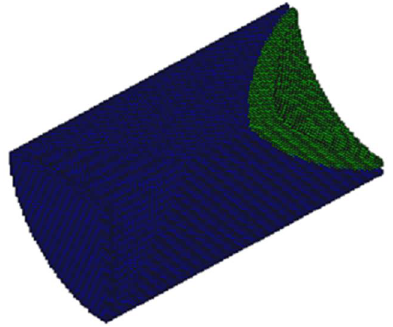
Figure 2. The quarter model for shaped charge numerical